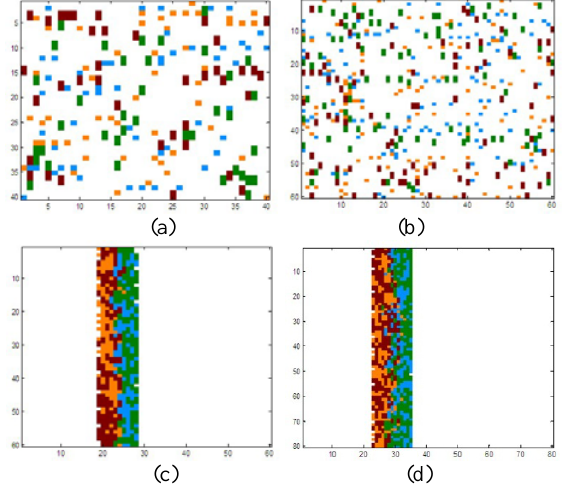
Fig. 9. The configurations of the paired pedestrians movement obtained at <d>=0.16 and paired rate=0.6. The channel sizes are set as 40× 40 , 60× 60 , 60× 60 and 80× 80 for (a), (b), (c), and (d), respectively. The cell in red represents the right paired pedestrian, and the orange cell represents the right single pedestrian, and the green cell represents the left paired pedestrian, and the blue cell represents the left single